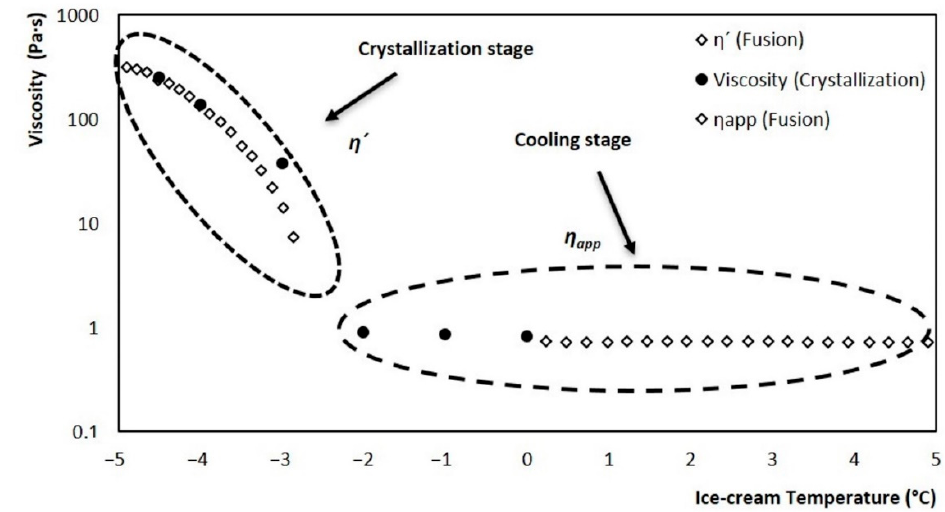
Figure 10. Evolution of ice cream apparent and dynamic viscosity: at a stirring rate of 3.33 rev/s. Crystallization stage ( − 2.8 °C to − 5 °C), cooling stage ( − 2.8 °C to 5 °C).